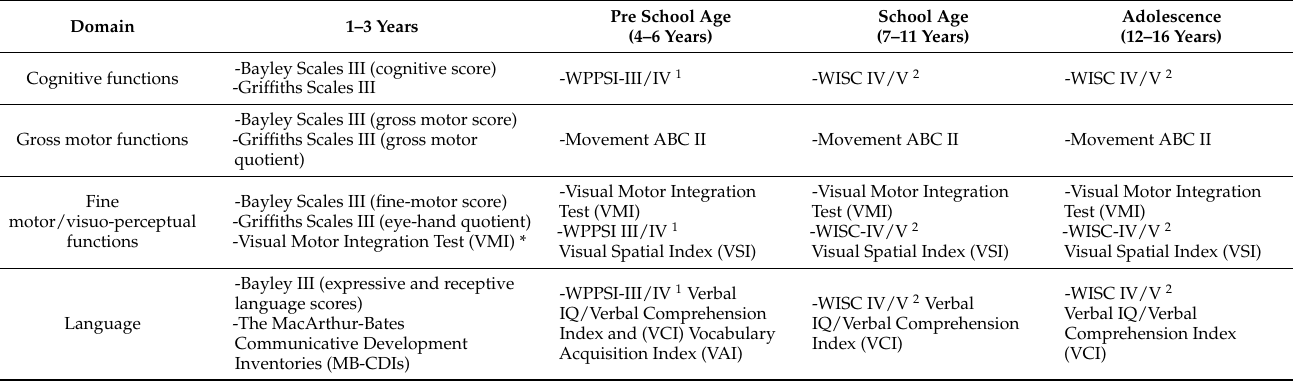
Table 2. Proposed follow-up of children with CNS malformation diagnosed in